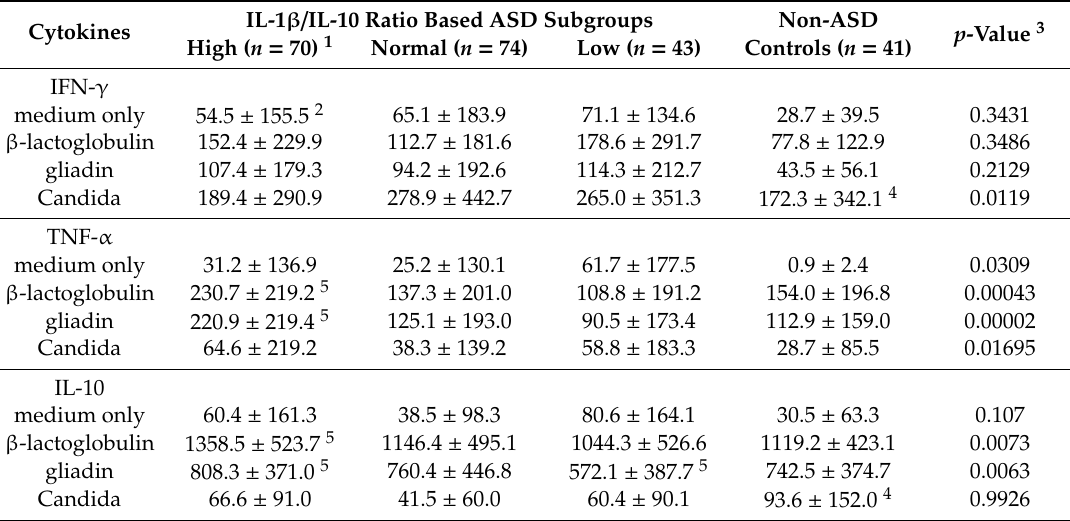
Table 4. T cell cytokine production by peripheral blood mononuclear cells (PBMCs) in response to β -LG, gliadin, or candida Ag in the IL-1 β / IL-10 based ASD subgroups.